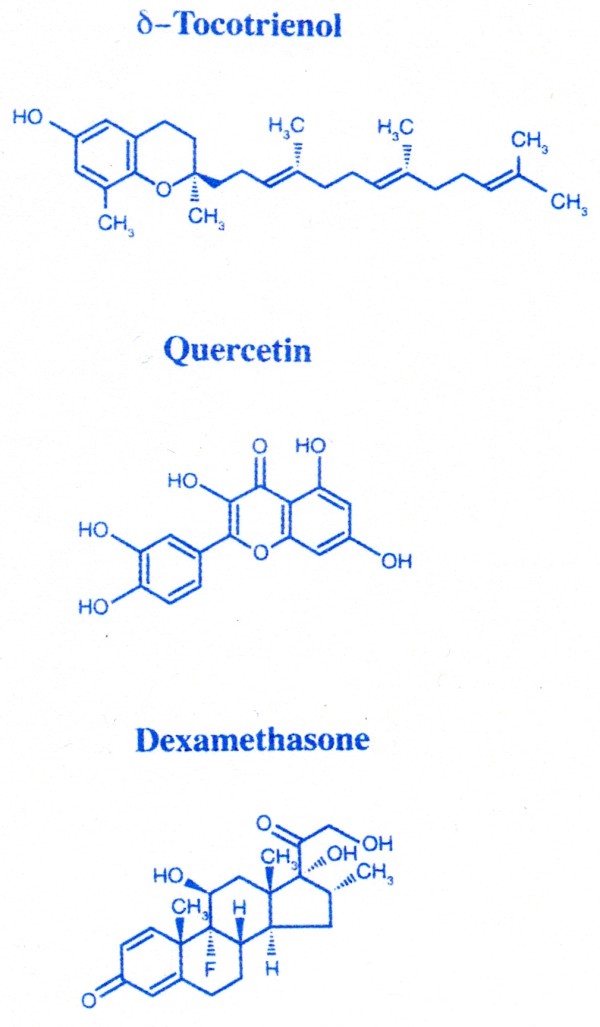
Chemical structures of various compounds used in this study.